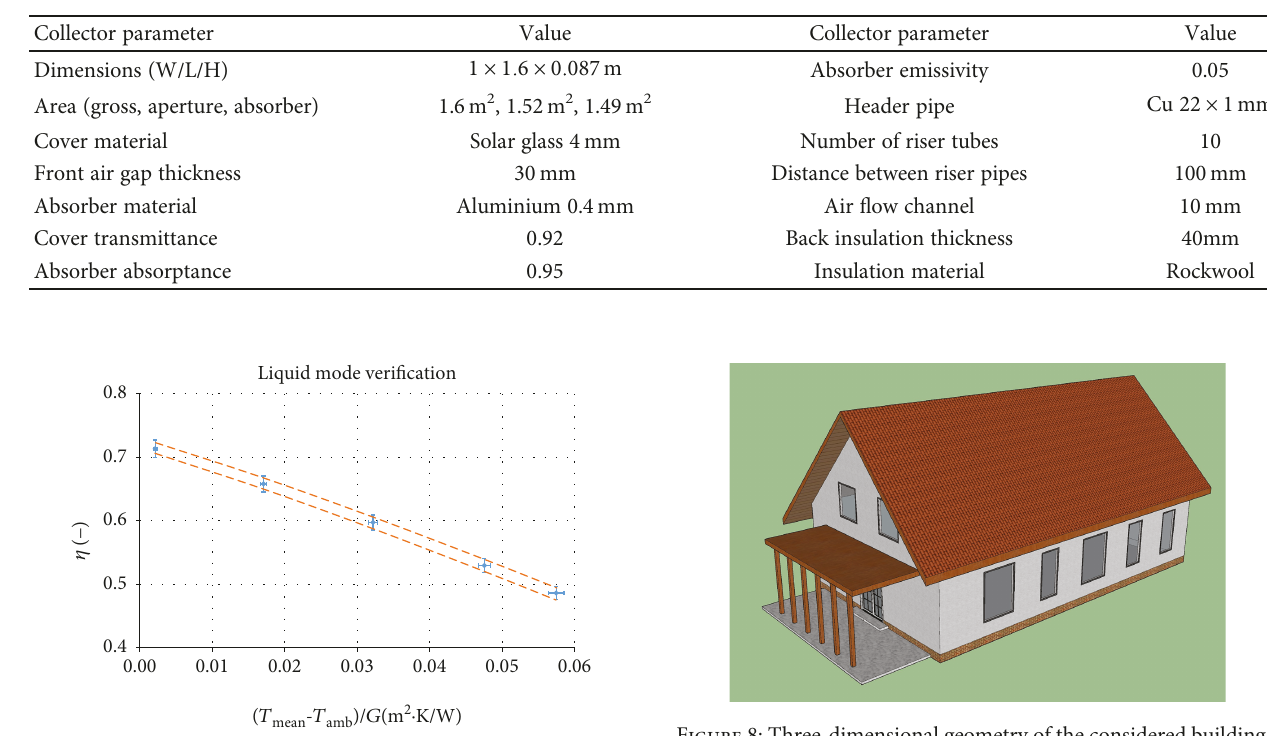
Table 1: Main parameters of the dual air/water solar collector.